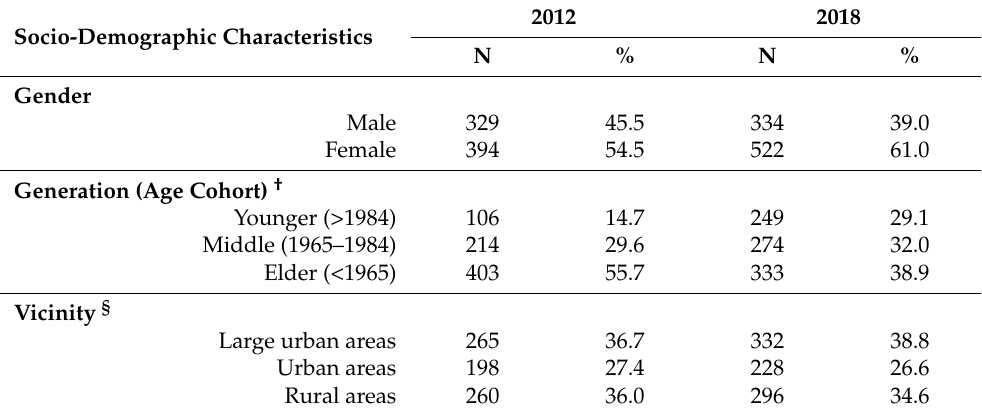
Table 1. Selected socio-demographic features of Roman Catholics in Lithuania (in 2012 and